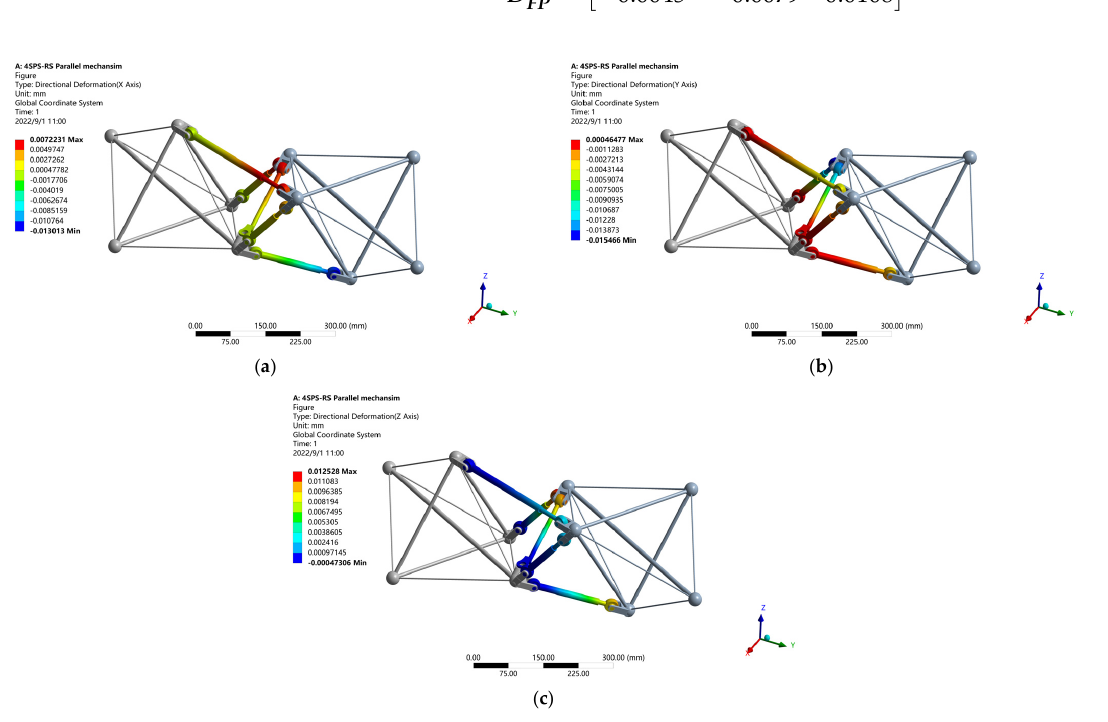
Figure 15. When the external load is the force of 100 N along the z -axis and the material is structural steel, simulation deformation of 4SPS-RS parallel mechanism in different coordinate directions: ( a ) x -axis; ( b ) y -axis; ( c ) z -axis.